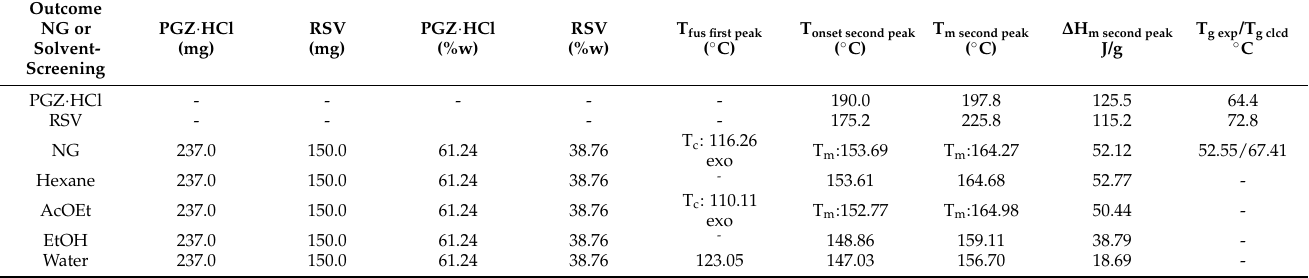
Table 1. Thermodynamic data of the different outcomes prepared by NG or